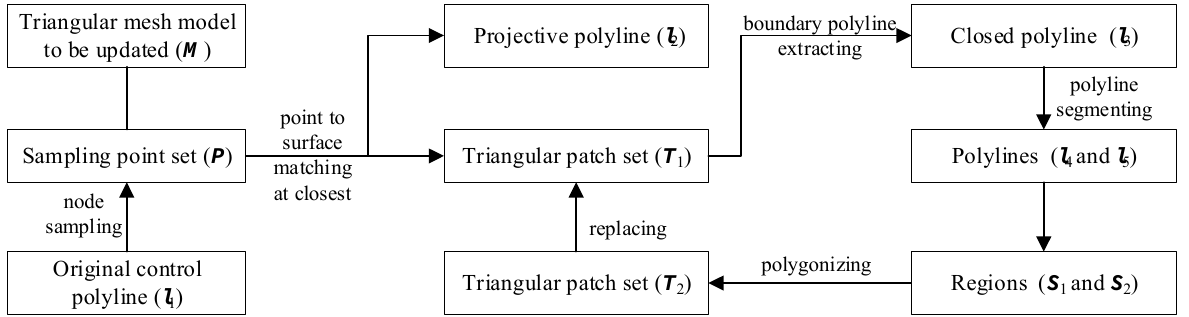
Figure 2. Mesh reconstruction flowchart of the projective neighborhood.